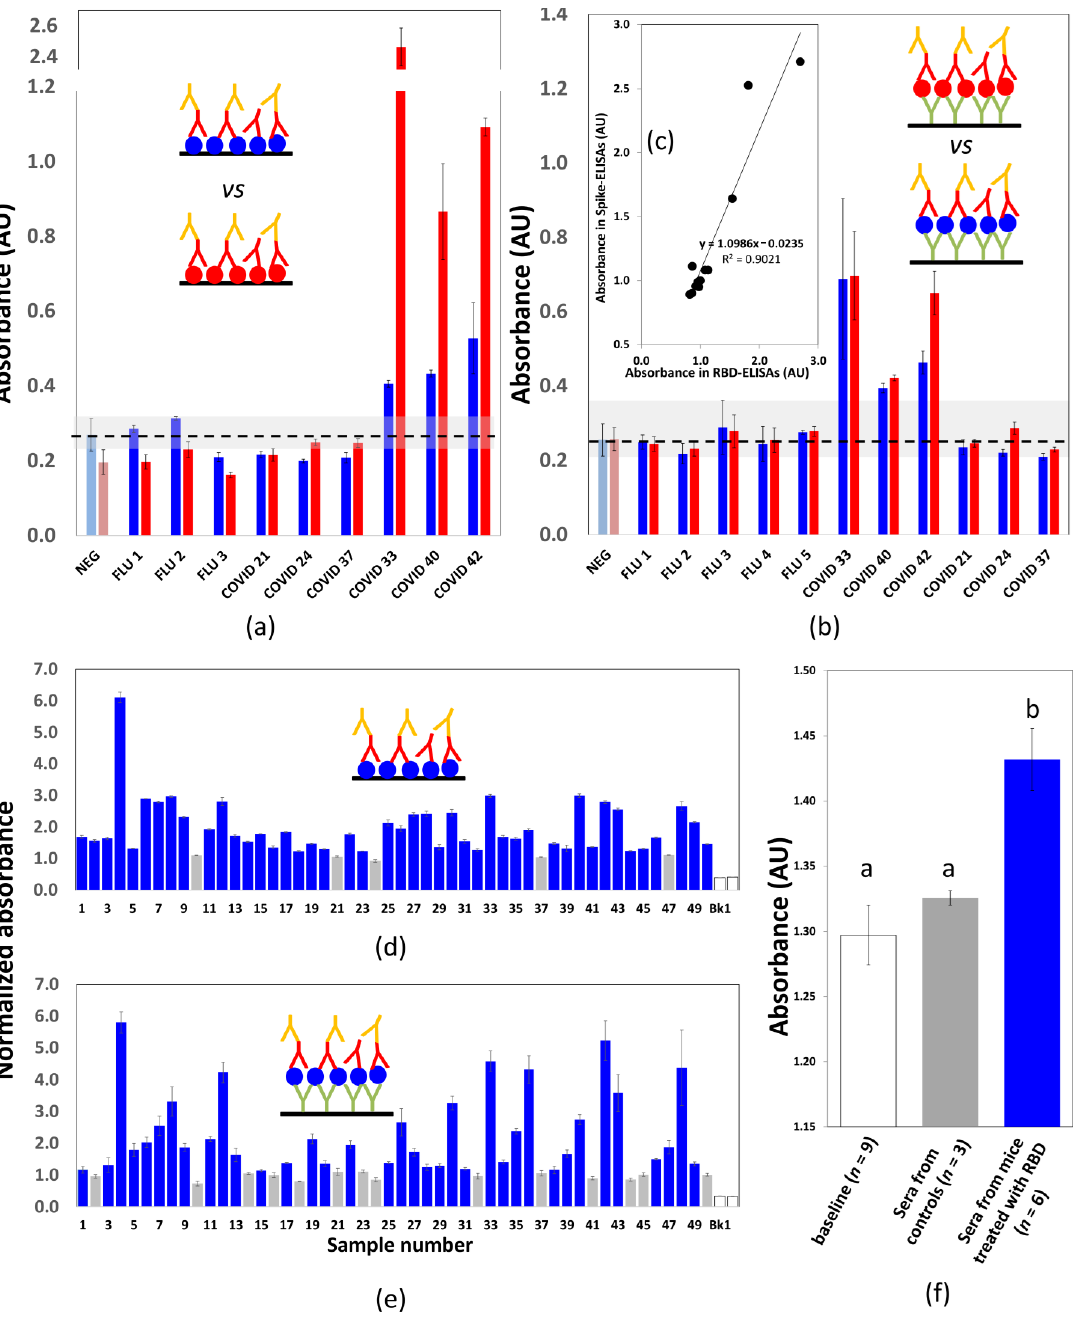
Figure 3. Binding of antibodies from human sera to S-RBD N318-V510 using direct and anti-histidine-mediated ELISAs. ( a ) Binding of antibodies from human sera, measured as absorbance readings, in direct ELISA experiments that used a commercial full-length spike (red bars) or the S-RBD N318-V510 protein (blue bars) as antigens. Serum samples were obtained from non-exposed volunteers (FLU X; collected during pandemic Influenza A/H1N1/2009) and from volunteers possibly exposed to SARS-CoV-2 (COVID X; collected during pandemic COVID-19). NEG bars indicate the average absorbance reading exhibited by serum samples from non-exposed volunteers. ( b ) Binding of antibodies from human sera, measured as absorbance readings, in anti-histidine mediated ELISA experiments that used a commercial full-length spike (red bars) or the S-RBD N318-V510 protein (blue bars) as antigens. Serum samples were obtained from non-exposed volunteers (FLU X; collected during pandemic Influenza A/H1N1/2009) and from volunteers possibly exposed to SARS-CoV-2 (COVID X; collected during pandemic COVID-19). NEG bars indicate the average absorbance reading exhibited by serum samples from non-exposed volunteers. ( c ) Graphic analysis of the correlation between titers obtained in anti-histidine-mediated ELISAs that used the commercial full-length spike (red bars) or the S-RBD N318-V510 protein (blue bars) as antigens. All